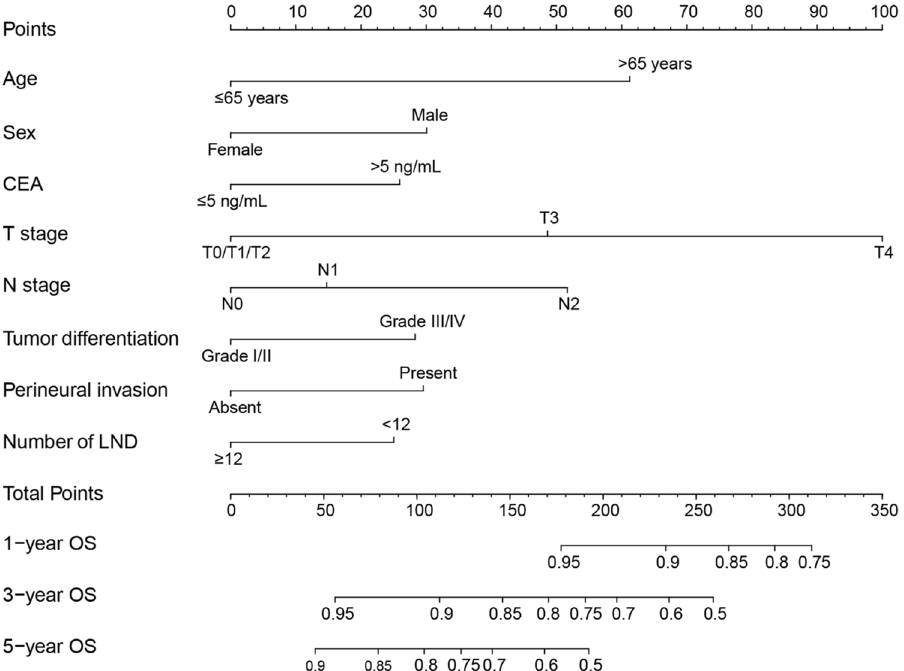
Figure 3. Locally advanced rectal cancer survival nomogram. OS overall survival, CEA carcinoembryonic antigen, LND dissected lymph nodes.